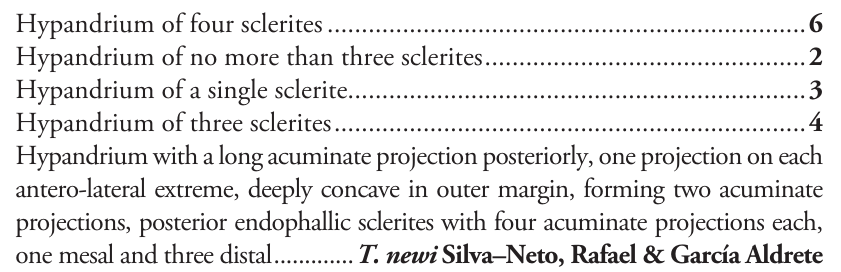
Hypandrium with a long acuminate projection posteriorly, one projection on each antero-lateral extreme, deeply concave in outer margin, forming two acuminate projections, posterior endophallic sclerites with four acuminate projections